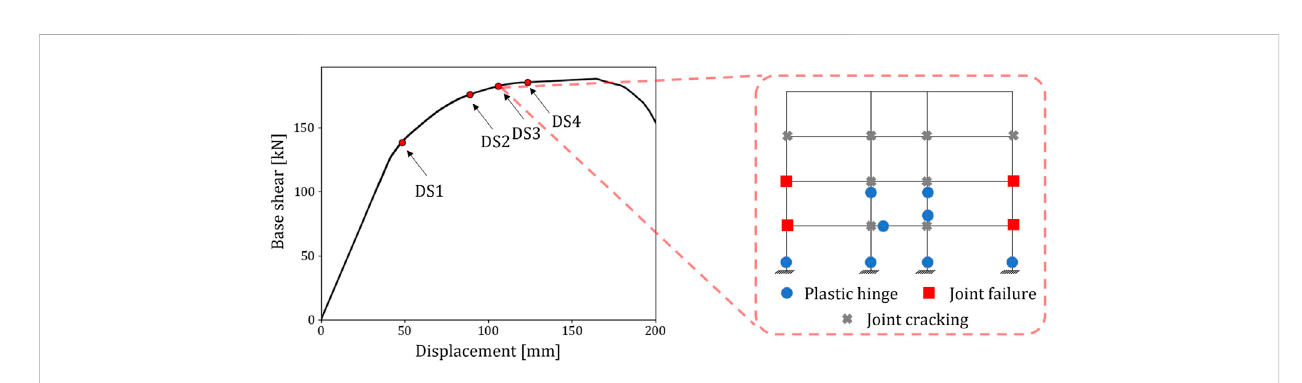
FIGURE 10 Pushover force-displacement curve and observed plastic mechanism at